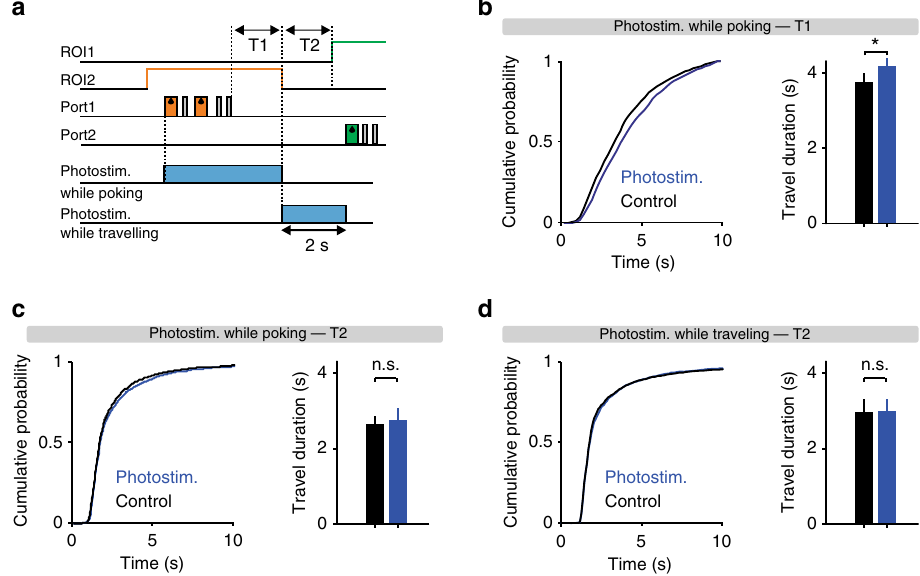
Fig. 4 Lack of effect of DRN 5-HT photostimulation on travel duration. a Schematic diagram of task events during a single trial showing the period of photostimulation. In the fi rst protocol (photostimulation while poking), photostimulation was triggered by the fi rst poke in 50% of correct trials, and in the second protocol (photostimulation while traveling), photostimulation was triggered by ROI exit in 50% of the correct trials and lasted for 2 s. We also de fi ned two relevant time periods: (T1) time-to-leave — the interval between the last poke and ROI exit, and (T2) travel — the interval between ROI exit and subsequent ROI entry. b Left: Cumulative distributions of T1 durations for photostimulated (blue) and control (black) trials, averaged across the population of SERT-Cre mice ( n = 10) in the photostimulation-during-poking protocol. Right: Bar plot showing the corresponding averages. * p < 0.05, Wilcoxon signed-rank test. c Left: Cumulative distributions of T2 durations for photostimulated (blue) and control (black) trials, averaged across the population of SERT-Cre mice ( n = 10) in the photostimulation-during-poking protocol. Right: Bar plot showing the corresponding averages. p > 0.05, Wilcoxon signed- rank test. d Left: Cumulative distributions of T2 durations for photostimulated (blue) and control (black) trials, averaged across the population of SERT-Cre mice ( n = 6) in the photostimulation-during-traveling protocol. Right: Bar plot showing the corresponding averages. p > 0.05, Wilcoxon signed-rank